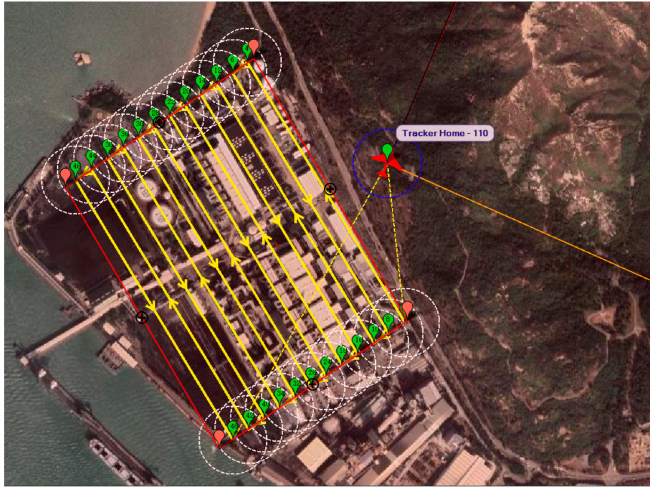
Figure 14. Auto-grid coverage paths generated by Mission